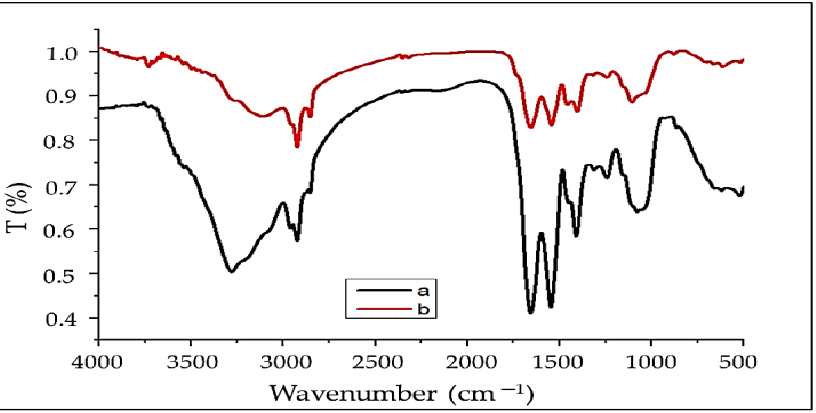
Figure 2. FTIR analysis of A. platensis nanoparticle before (a) and after (b) adsorption of MBD. The FTIR spectra of A. platensis display the hydroxyl and amine groups’ characteristic absorption bands, which range from 3111 to 3729 cm − 1 , for both before and after adsorption, respectively [28]. The band positions at 2923.91 cm − 1 related to the stretching of C–H [14]. Moreover, asymmetric and symmetric stretching of the CH 2 group is related to the bands at 2923 and 2853 cm − 1 , respectively [77]. The carbonyl group of the carboxylic acid is ascribed to the sharp band at 1656 cm − 1 [78,79]. The overlapping amongst broad bands of N – O and N – H with strong peaks for amide has been shown as a single band at 1654 and 1656 cm −1 [80]. In addition, ring modes of aromatic rings are ascribed to many